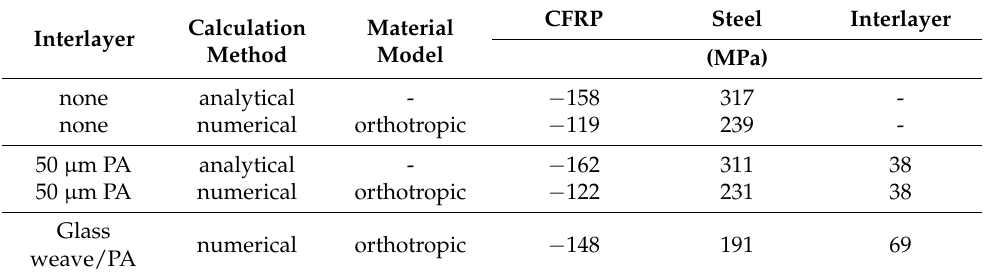
Table 3. Calculated thermal residual stresses (S11 → fiber direction) using different methods and composite layups.